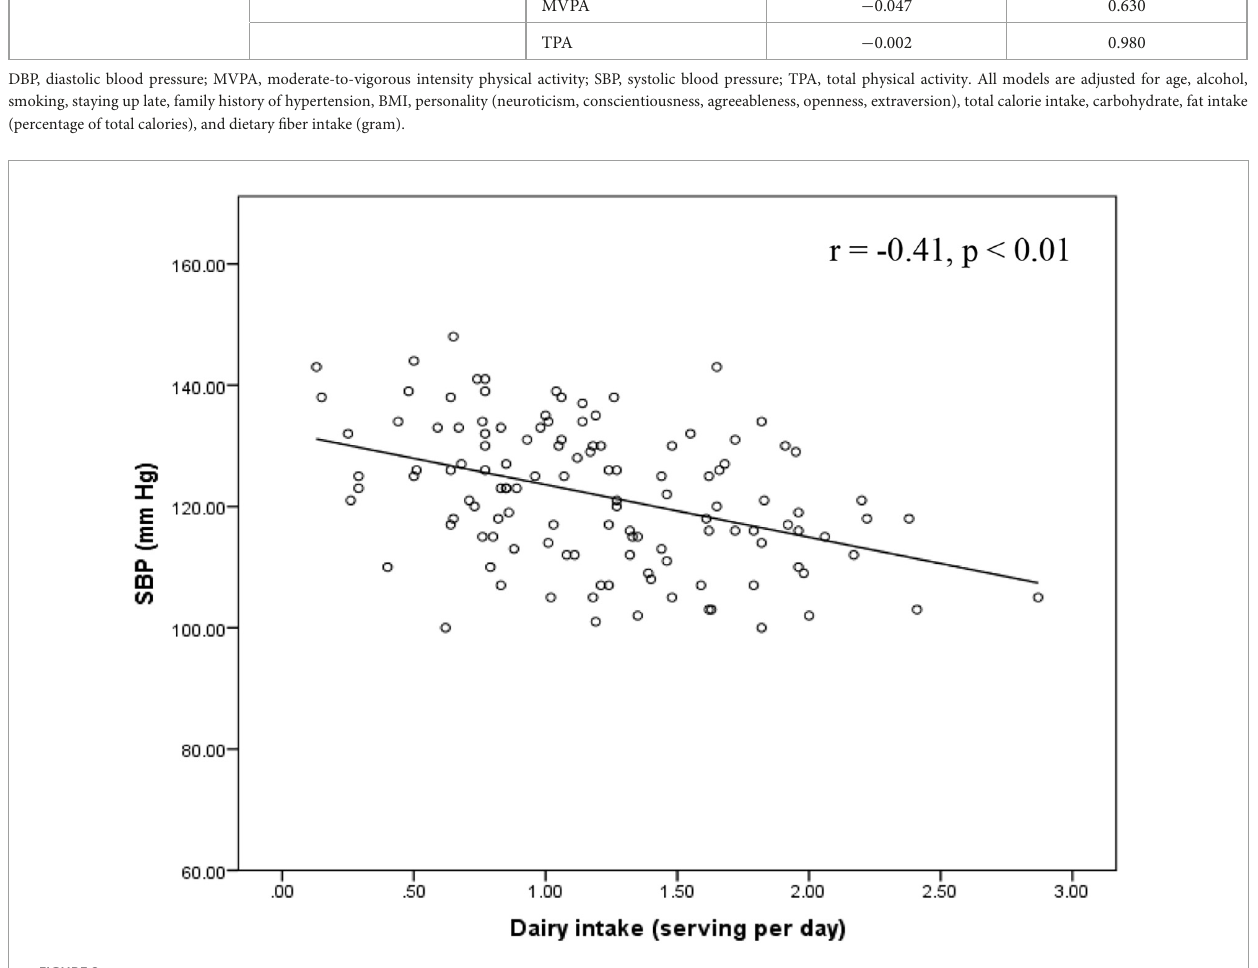
FIGURE2 Relationship between SBP and dairy intake in the total sample. SBP, systolic blood